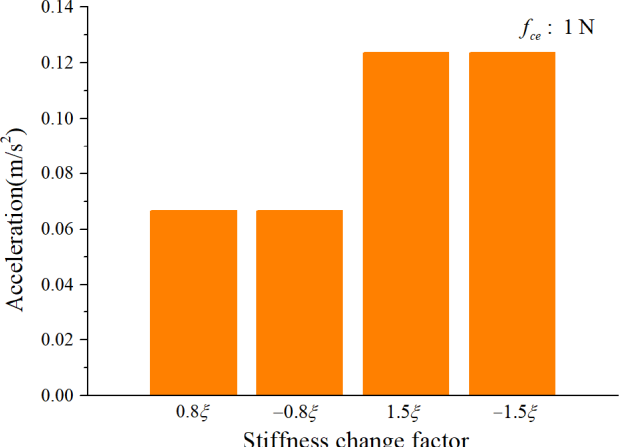
Figure 13. Acceleration RMS.